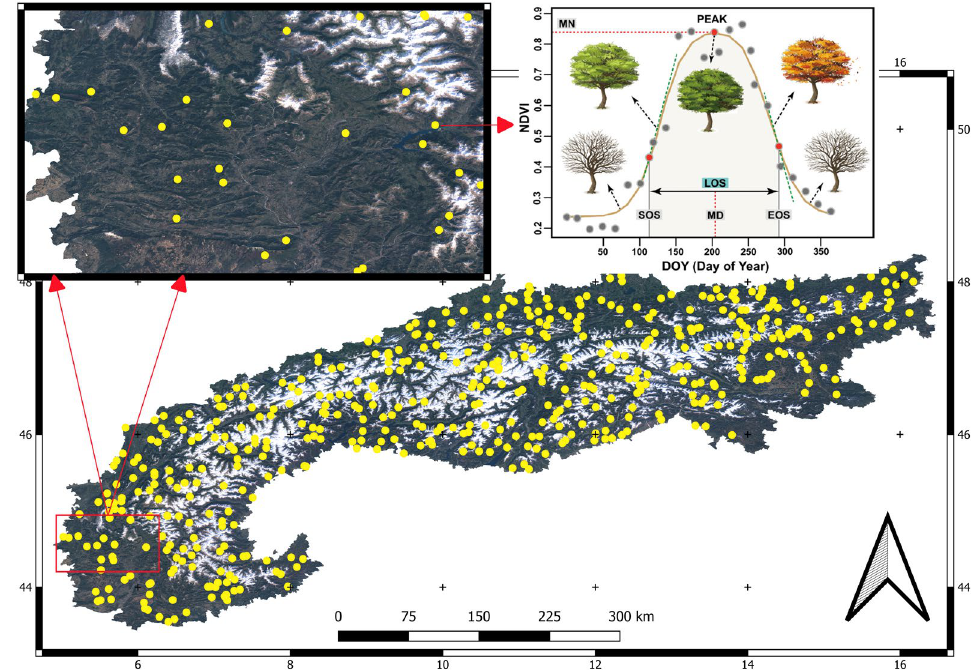
Figure 3. Validation points randomly selected over the AOI in vegetated areas with NDVI threshold greater than 0.3. EPSG: 4326.